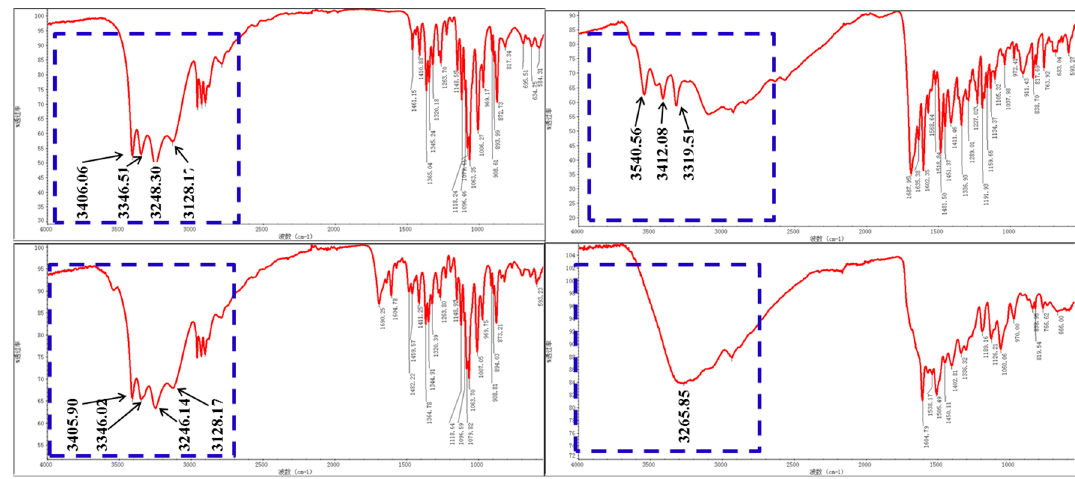
Figure 3. FTIR spectra of ( A ) 2-DG, the signals at 3406 cm − 1 , 3346.51 cm − 1 , 3248.30 cm − 1 , and 3128.17 cm − 1 in blue dotted box represent the O–H peaks; ( B ) folic acid, the signals at 3540.56 cm − 1 , 3412.08 cm − 1 , and 3319.51 cm − 1 represent the N–H and O–H peaks; ( C ) a physical mixture of folic acid and 2-DG (FA-2-DG/PM), the signals represented by their respective structures are also obvious; and ( D ) FA-2-DG, none of the N–H and O–H peaks can be clearly identified.